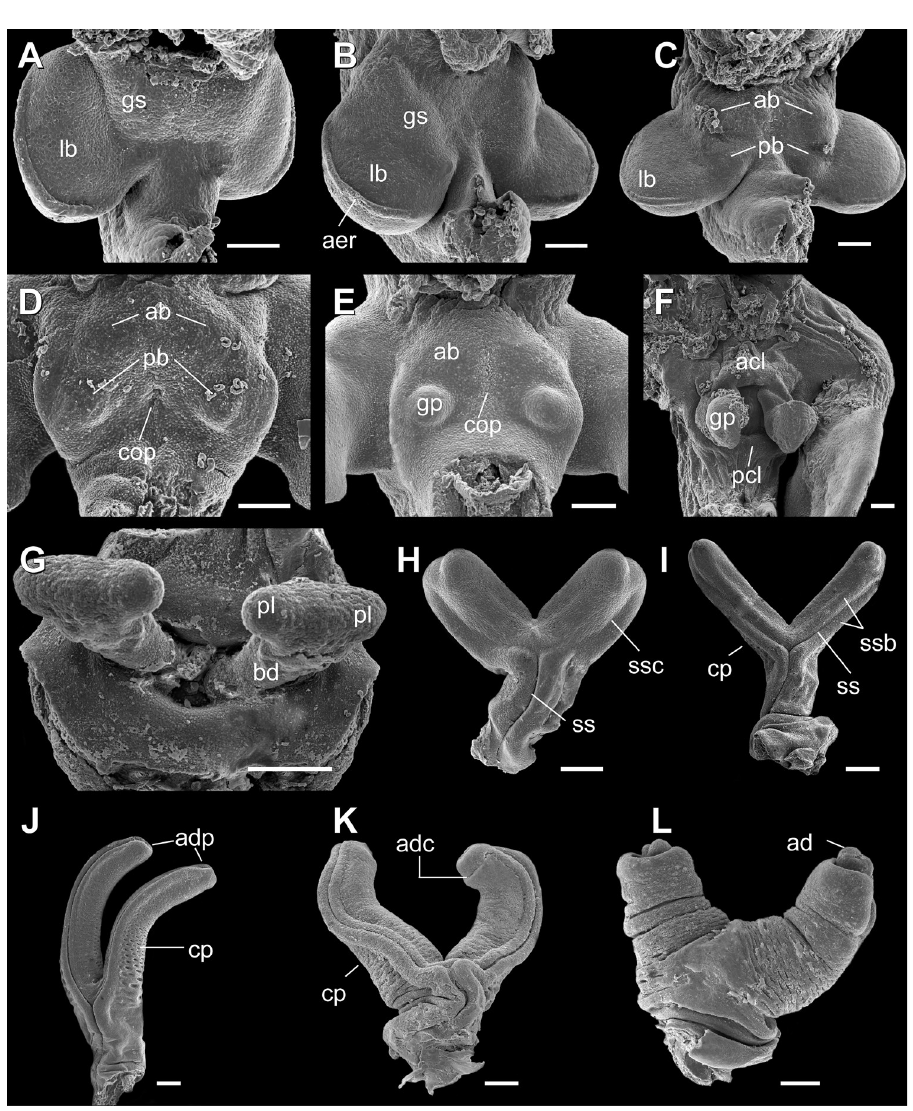
Fig 2. Hemipenial development of Tropidurus torquatus under SEM analysis. A, stage 28; B, stage 29; C; stage 30; D, early stage 31; E, late stage 31; F, late stage 32; G, stage 36; H, stage 37; I, stage 38; J, stage 40; K, stage 41; L, stage 42. Legends: ab, anterior bud; acl, anterior cloacal lip; ad, apical disc; adc, apical disc constriction; adp, apical disc primordia; aer, apical epidermal ridge; tr, hemipenial truncus; cop, cloacal opening primordia; cp, calyces primordia; gp, genital primordia; gs, genital swelling; lb, hind limb bud.; pb, posterior bud; pcl, posterior cloacal lip; pl, primordium of lobes; ss, spermatic sulcus; ssb, spermatic sulcus borders; ssc, spermatic sulcus constriction. Scale bar: A-F, 100 μ m; G-L, 200 μ